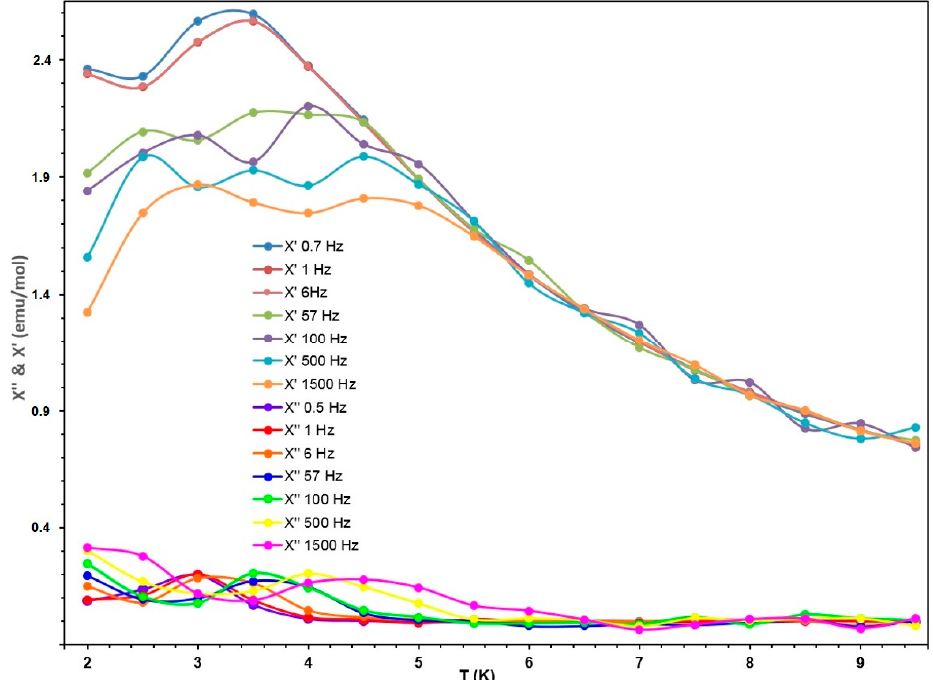
Figure 16. Variable-temperature real ( χ ’, top) and imaginary ( χ ” , bottom) ac molar susceptibility data for 13 under H dc = 100 Oe and H ac = 3.5 Oe. Solid lines are guides [46].